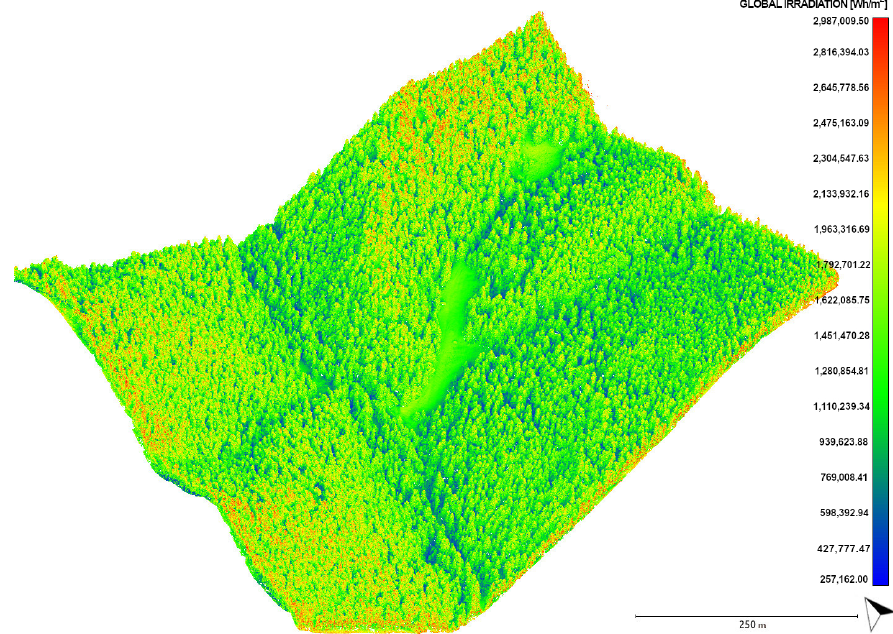
Figure 3. The annual global solar irradiation in the Suchá valley, Slovakia. Data source: ÚGKK SR